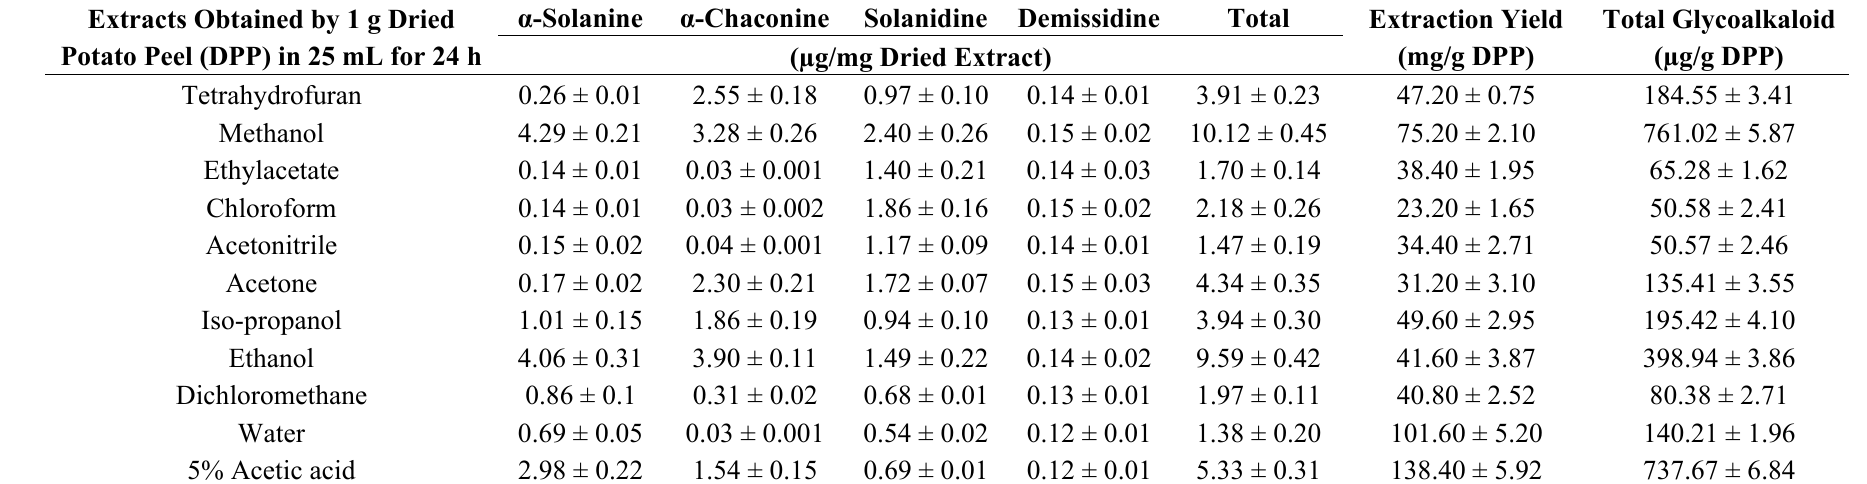
Table 1. Efficacy of various solvents in the extraction of glycoalkaloids from potato